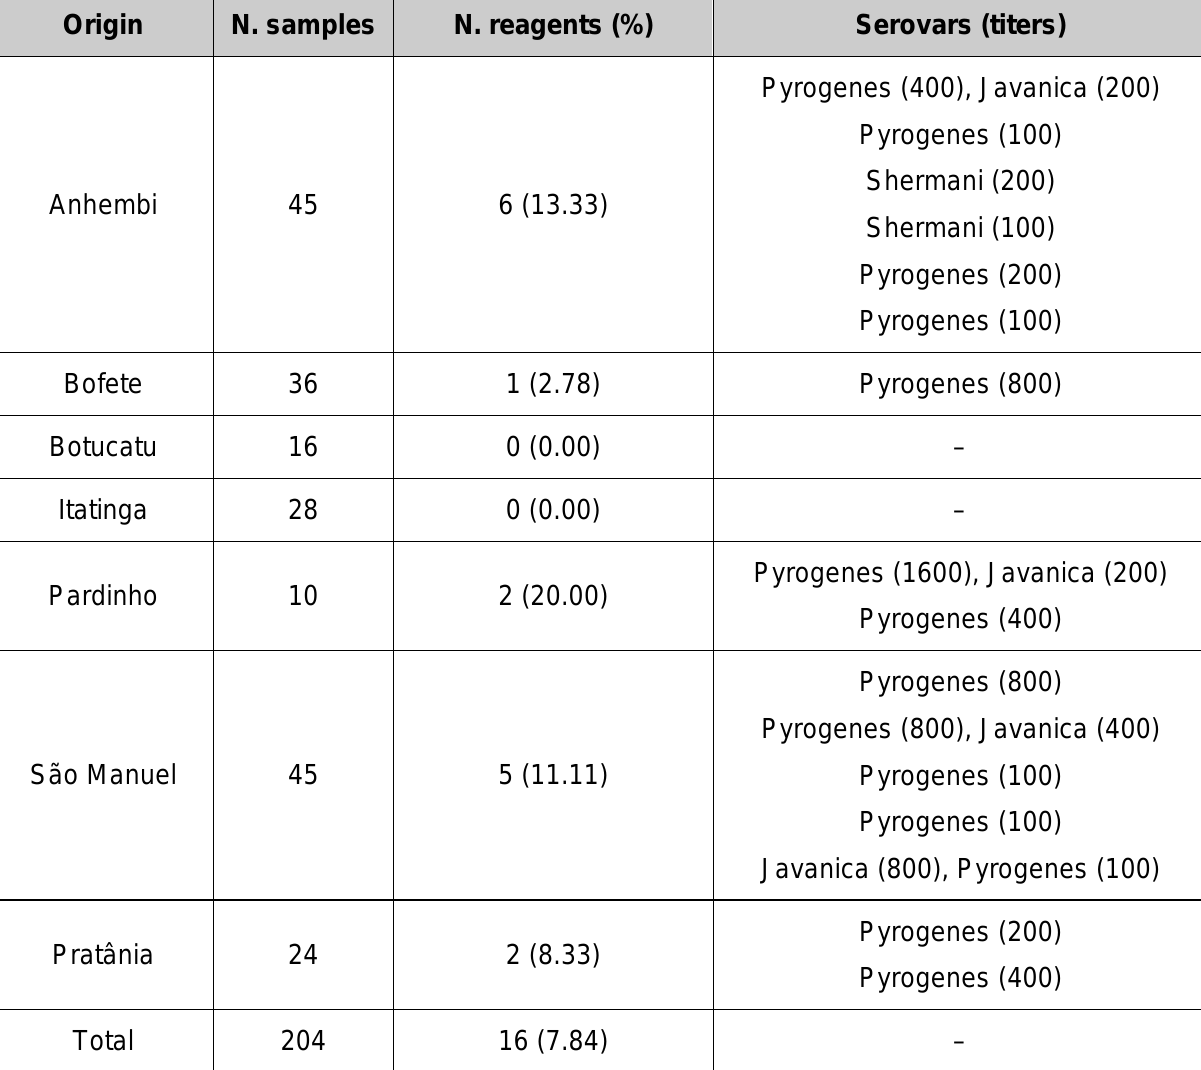
Table 1. MAT-l results of the studied Desmodus rotundus , with respective serovars and reactive